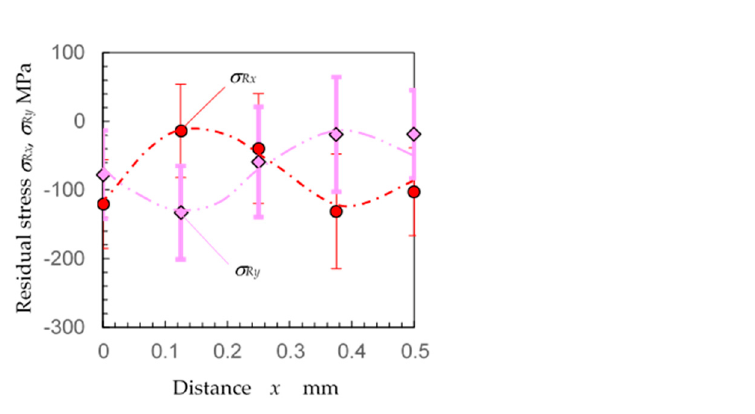
Figure 17. Distribution of the residual stress σ Rx and σ Ry changing with distance x (specimen